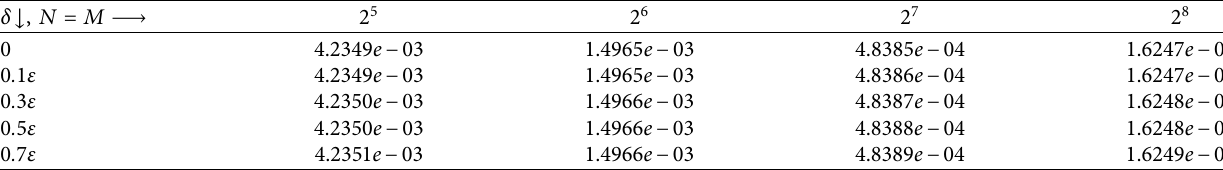
Table 4: Maximum absolute error of Example 2 using the proposed method for different values of delay parameter at ε � 2 − 10 . δ ↓ , N � M ⟶